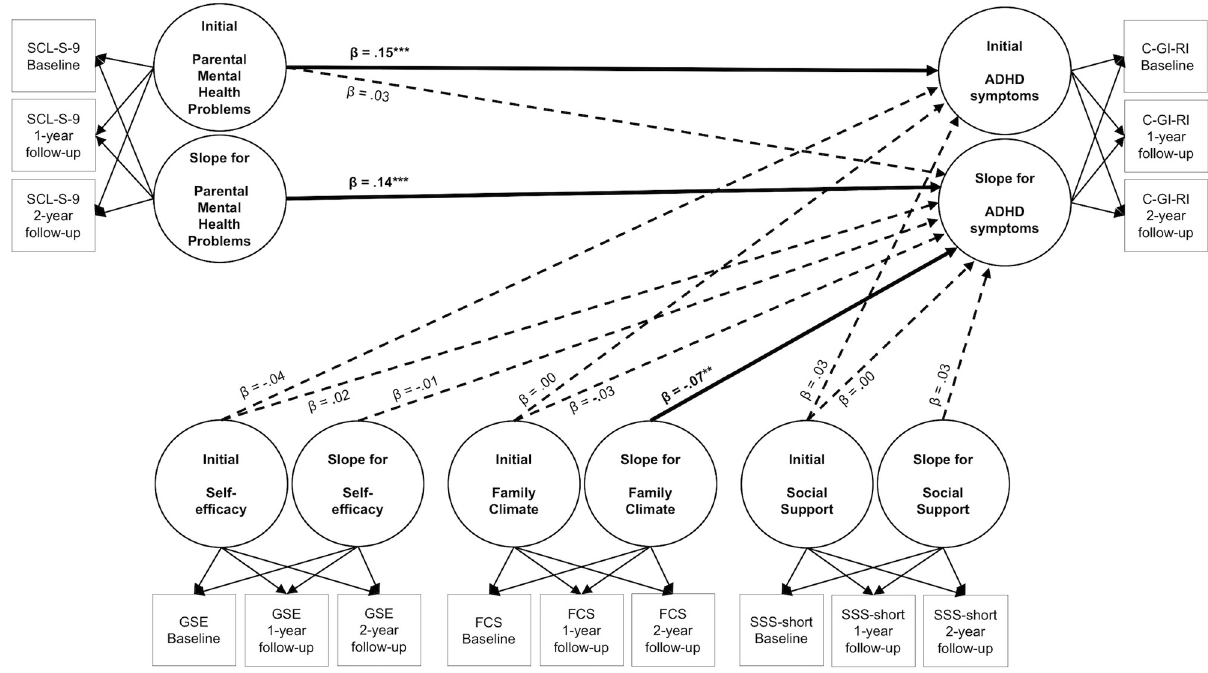
Fig 1. Effects of risk and protective factors on symptoms of attention-deficit/hyperactivity disorder in children and adolescents. Continuous lines mark significant effects, interrupted lines indicate non-significant effects, resulting from regression Models A0 and B0. n = 1,384. ADHD = attention- deficit/hyperactivity disorder; C-GI-RI = subscale restless-impulsivity of the Conners Global Index [49, 50]; SCL-S-9 = Symptom-Check List Short version-9 [61]; GSE = General Self-Efficacy Scale [63, 64]; FCS = an eight-item score based on the Family Climate Scale [65]; SSS-short = eight items of the German version of the Social Support Survey [67]; β = standardized regression coefficient; reported β s are resulting from Models A0 and B0; ��� p � 001 ; �� p � 01 ;